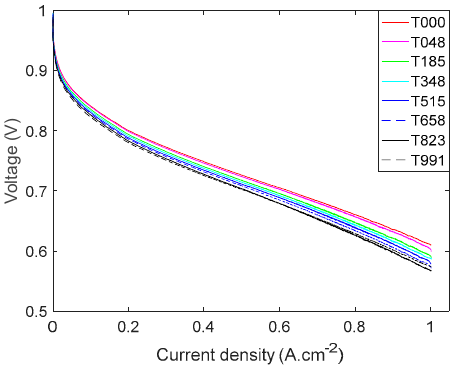
Figure 2. Collected V-I curves during PEMFC test.